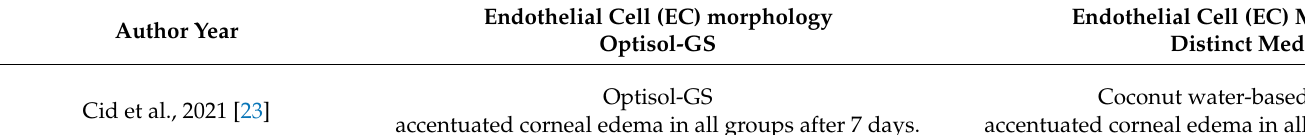
Table 10. Endothelial Cell (EC) morphology